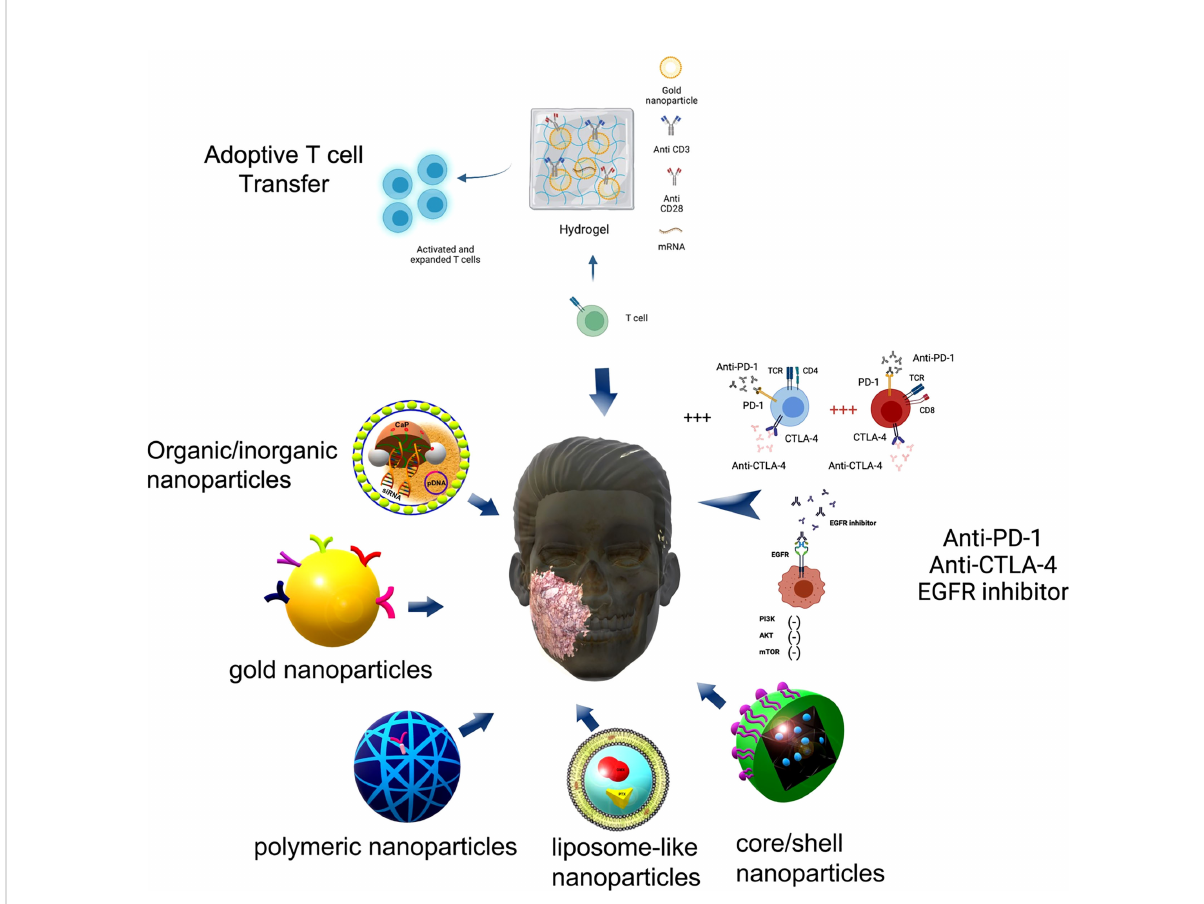
FIGURE 5 Nanoparticles proposed for immunotherapy. Some nanoparticles proposed for immunotherapy are pointed out here comprising organic/ inorganic nanoparticles composed by lipid membranes and Calcium-Phosphate (CaP) for dual-targeted therapy using a small interfering RNA (siRNA) against immune checkpoint ligand PD-L1 and the plasmid DNA (pDNA) encoding immunostimulatory cytokine IL-2. Gold nanoparticles coated with antibodies such as cetuximab inhibit the proliferative downstream pathway PI3K/Akt/mTOR axis ( — ) due to EGFR blocking. Polymeric nanoparticles and core/shell nanoparticles can carry an anti-CTLA-4 siRNA or anti PD-1 antibodies increasing the percentage (+++) of effector CD4+ T cells and CD8+ T cells. Liposome-like nanoparticles carry immunotherapy drugs such as Gemcitabine (GEM) and Paclitaxel (PTX) working as drug delivery system. Figure generated using Biorender